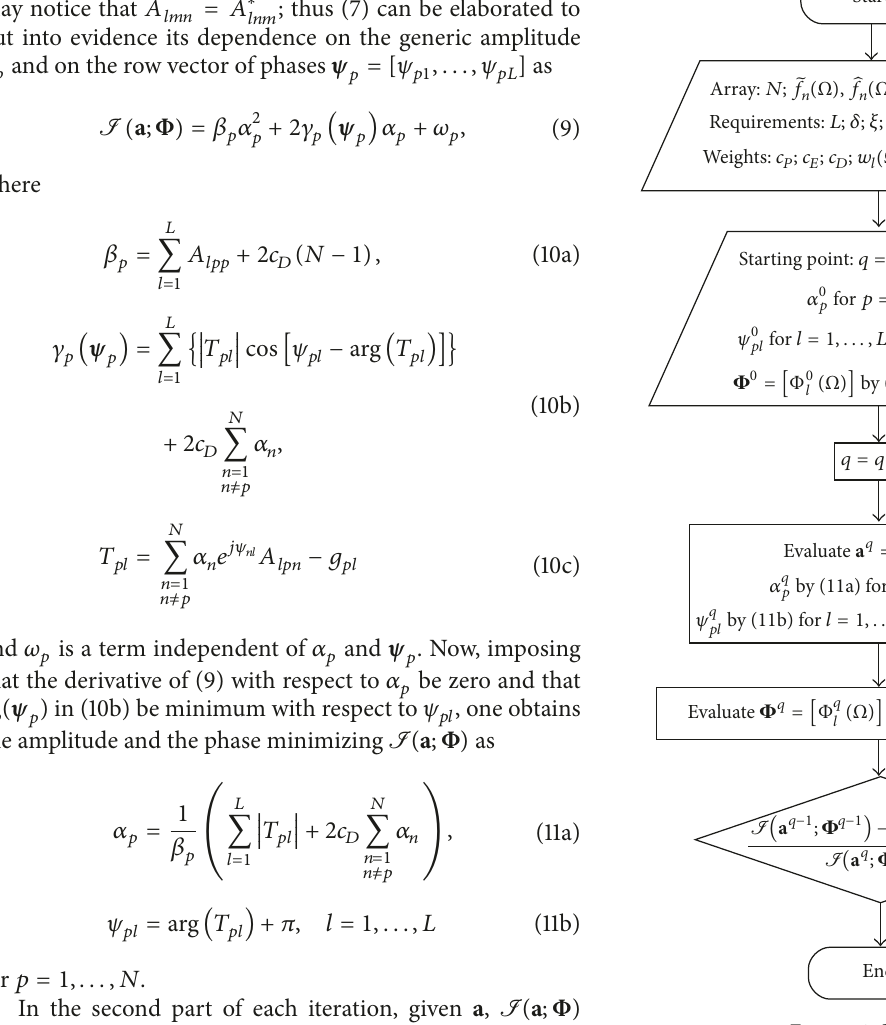
Figure 1: Synthesis